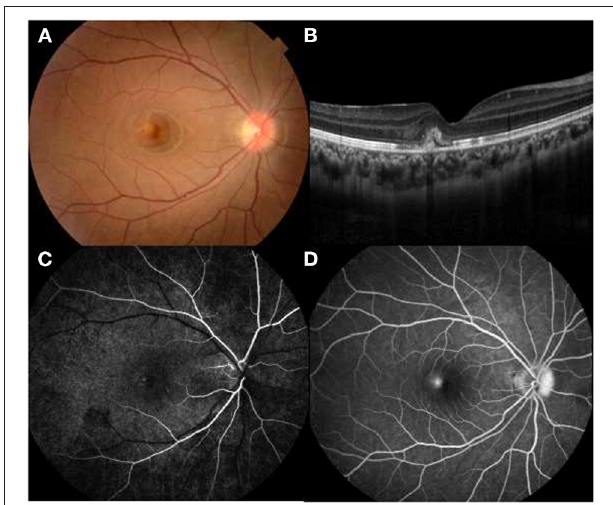
FIGURE 3 | Multimodal imaging of a 14-year-old female with idiopathic choroidal neovascularization. Her BCVA was 0.9 logMAR in the right eye and 0.1 logMAR in the left eye. (A) A parafoveal yellowish lesion was noted on funduscopy. (B) OCT showed a hyperreflective area located in subretinal space with arounding serous retinal detachment. (C,D) Hyperfluorescence in the early phase and leakage in the late phase FFA revealed an active lesion